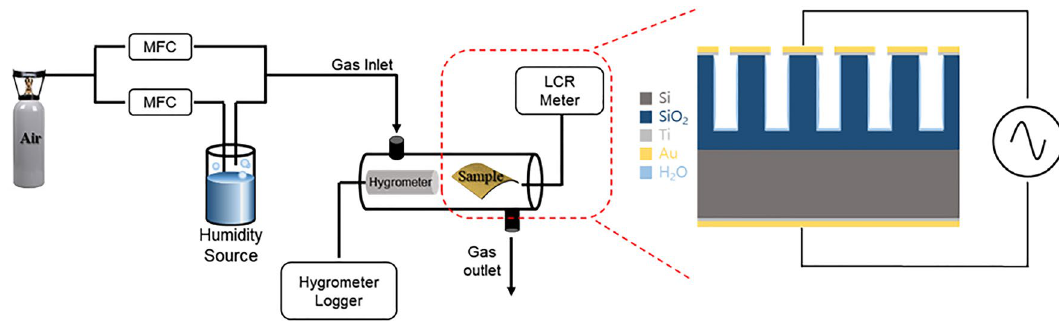
Figure 5. A schematic illustration of the humidity sensing measured by an ellipsometer, as described in Fig. S2. The SiO 2 layer formed in the porous Si structure might be expected to be thicker than the thickness of 145.6 nm in the SiO 2 layer oxidized on a bare Si wafer for 6 h, due to the increased surface area for the oxidation. The cross section of the SiO 2 /Si film was analyzed by high-resolution TEM (HRTEM), as shown in Fig. 4b. The interface of the two layers, consisting of SiO 2 in the amorphous phase and Si in the single crystalline phase, was clearly distinguished in the HRTEM image. The Si layer prepared by the exfoliation of a single crystal Si (1 0 0) wafer clearly maintained the well-oriented lattices. The HRTEM image of the oxidized SiO 2 layers unable to observe any structure in the amorphous phase. Additionally, the amorphous SiO 2 structure and the single crystal Si structure were confirmed with the fast Fourier transform converted from selected area electron diffraction patterns (FFT SAED), as shown in the insets ( i and ii ) of Fig. 4b, respectively. The image of a freestanding bendable SiO 2 /Si film including a metal oxide layer is shown in Fig. 4c. The capacitive humidity sensing performance of the fabricated porous SiO 2 /Si film was characterized by con- trolling the frequency and RH. To measuring the variation of the capacitance of the SiO 2 /Si film, Cu wires were connected with Au electrodes and were deposited on the top and bottom sides of the fabricated SiO 2 /Si film. The variation of the capacitance between the top and bottom of electrodes was measured to characterize the humid- ity sensing properties. The SiO 2 /Si film was transferred to a humidity sensing chamber. Figure 5 is a schematic illustration of the humidity sensing environment. The humidity of the chamber was controlled by changing the ratio of dry gas to wet gas. The capacitance of the porous SiO 2 /Si sensing material with leak conduction can be described by Eq. (1), where C 0 , ε r , γ , ω , and ε 0 are the capacitance, and relative dielectric constant of and ideal capacitor, conductance, angular frequency, and permittivity of free space, respectively 20 . The capacitance of the sensing materials is proportional to the reciprocal of the angular frequency, 1/ ω , and the conductance, γ . The sensitivity for the humidity sensing response was calculated by the following Eq. (2), where C RH and C dry were the capacitance under the varied RH and the capacitance of the lowest RH of 1.63%, respectively. Figure 6a shows the sensitivity of the fabricated porous SiO 2 /Si film as a function of frequency and RH. The frequency was varied as 100 kHz, 500 kHz, and 1 MHz, and the RH ranged from 13.8 to 79.0%. As described in Eq. (1), the increase in the applied frequency shows a reduced sensitivity in the range of high RH. No sensing properties were demonstrated for frequencies higher than 1 MHz. The adsorbed water molecules on the sensing material under high frequencies, with a quickly changing electrical field, have insensitive polarization and a reduced dielectric constant 21 . The humidity sensitivity of the porous SiO 2 /Si film linearly increases with an increase in RH. The variation of capacities for the humidity sensing response in the porous SiO 2 /Si film is attributed to the varied conductance from water molecules adsorbed on the surface of porous SiO 2 . Therefore, the enhanced sensitivity in high RH conditions can be explained by the increased polarization of the adsorbed water molecules on the surface of the porous SiO 2 in the electrical field. respectively.(1) Figure 6b shows the hysteresis characteristics for the capacitive humidity sensing response of the fabricated porous SiO 2 /Si film. The solid square line and solid circle line in Fig. 6b stand for the adsorption of water with increasing RH and for desorption with decreasing RH, respectively. The hysteresis properties were calculated using Eq. (3), where H e , ∆ H max , and F FS are the hysteresis error, a maximum difference of sensitivity between adsorption and desorption at the same RH, and a full-scale output (Sensitivity at 13.8% − Sensitivity at 78.4% ) 22,23 . The hysteresis error is 5.0% for a RH of 50.1%. The humidity sensitivity after bending test of 5 times was shown in Fig. S3. After the bending test, the sensitivity and linearity were changed to 392% at a RH of 79% and 0.989, respectively. A single sensing curve at 100 kHz at a RH of 71.4% is shown in Fig. 6c. The response time and recovery time for humidity sensing, defined as the time to reach 90% of the total variation, were 18 s and 30 s,